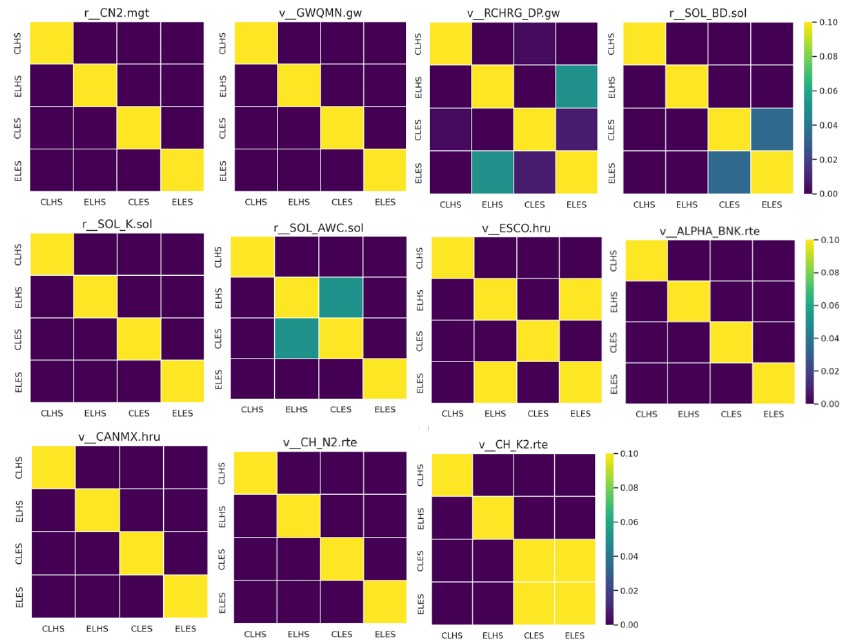
Figure A5. Crosswise comparison of model parameter ranges with the p -value of the Mann-Whitney- U test during initial validation. The parameter descriptions and units are listed in Table